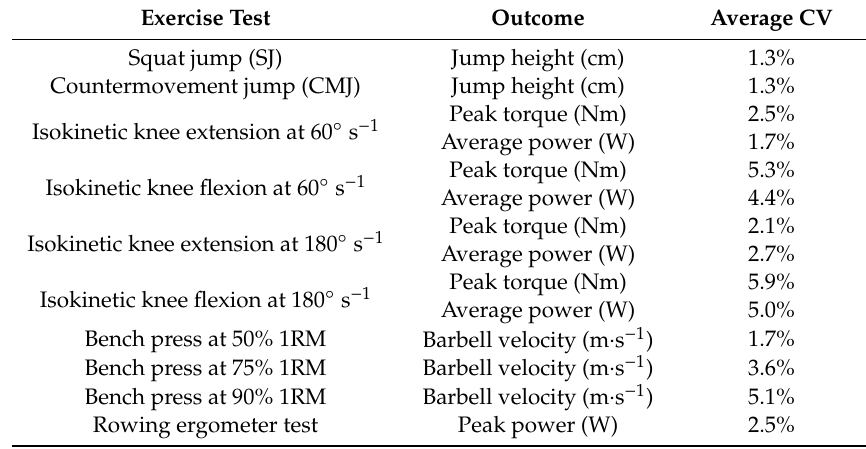
Table 1. Test–retest reliability of the exercise protocol; determined on a pilot sample of five